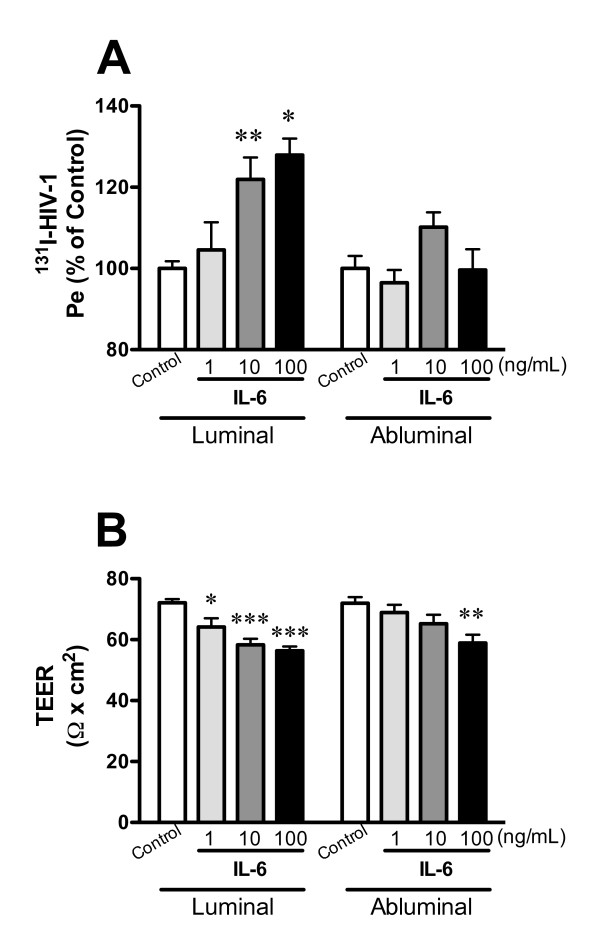
Functional polarity to IL-6 in BMEC permeability of HIV-1 (A) and TEER (B). BMECs were exposed to IL-6 (1, 10, and 100 ng/mL) in the luminal or abluminal chamber for 4 hr. In panel A, results are expressed as % of control. The control values of permeability coefficient for 131I-HIV-1 in panel A was 1.03 ± 0.11 × 10-5 and 1.07 ± 0.08 × 10-5 cm/min for the luminal and abluminal control, respectively. Values are means ± SEM (n = 3-12). *P < 0.05, **P < 0.01, ***P < 0.001, significant difference from each corresponding control.